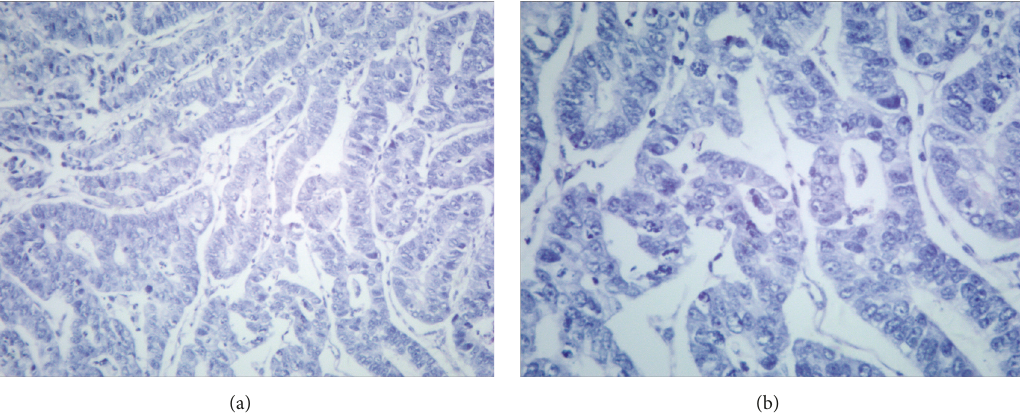
Figure 2: Microscopic findings at the time of diagnosis. Well differentiated tubular adenocarcinoma ((a) H&E, × 100; (b) H&E, ×